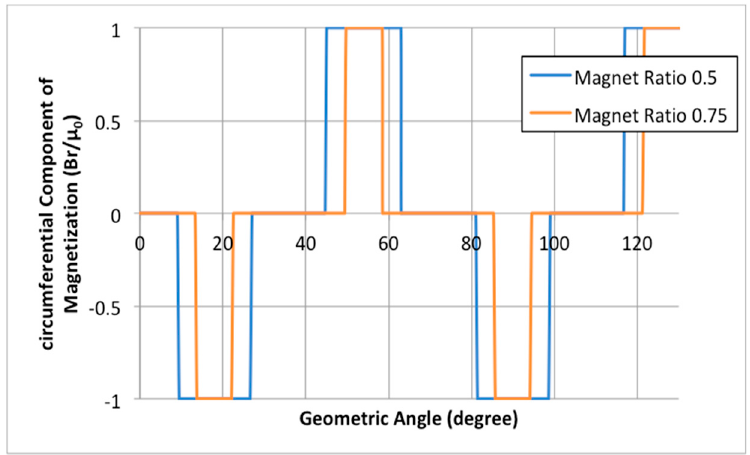
Figure 3. Circumferential Component of Magnetization for Two Magnet Ratios (0.5 and 0.75).